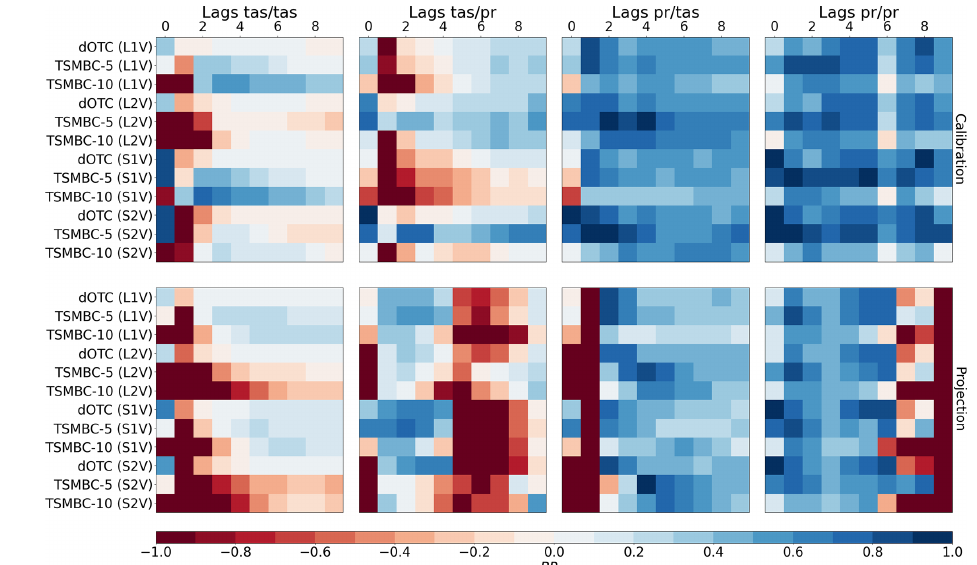
Figure 9. Same as Fig. 8, but with a normalization by column (i.e. by given lag), before computing the BR W values. Hence, the BR W values of a given method for two different lags cannot be compared with this normalization. The closer the BR W value is to 1, the closer the results are to the reference and therefore the better they